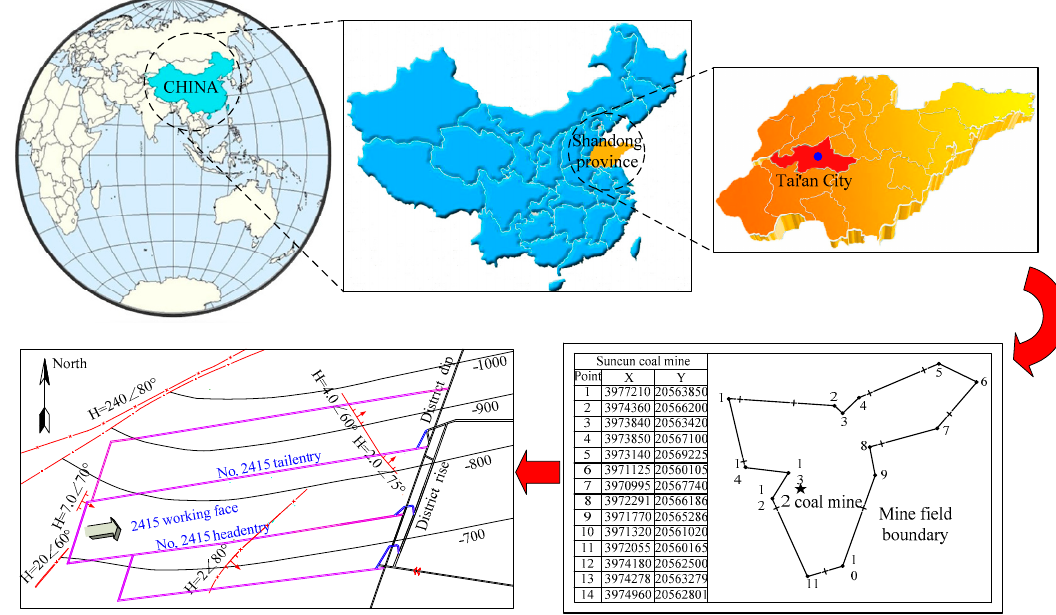
Figure 1. Layout of mine location and 2415 working face.